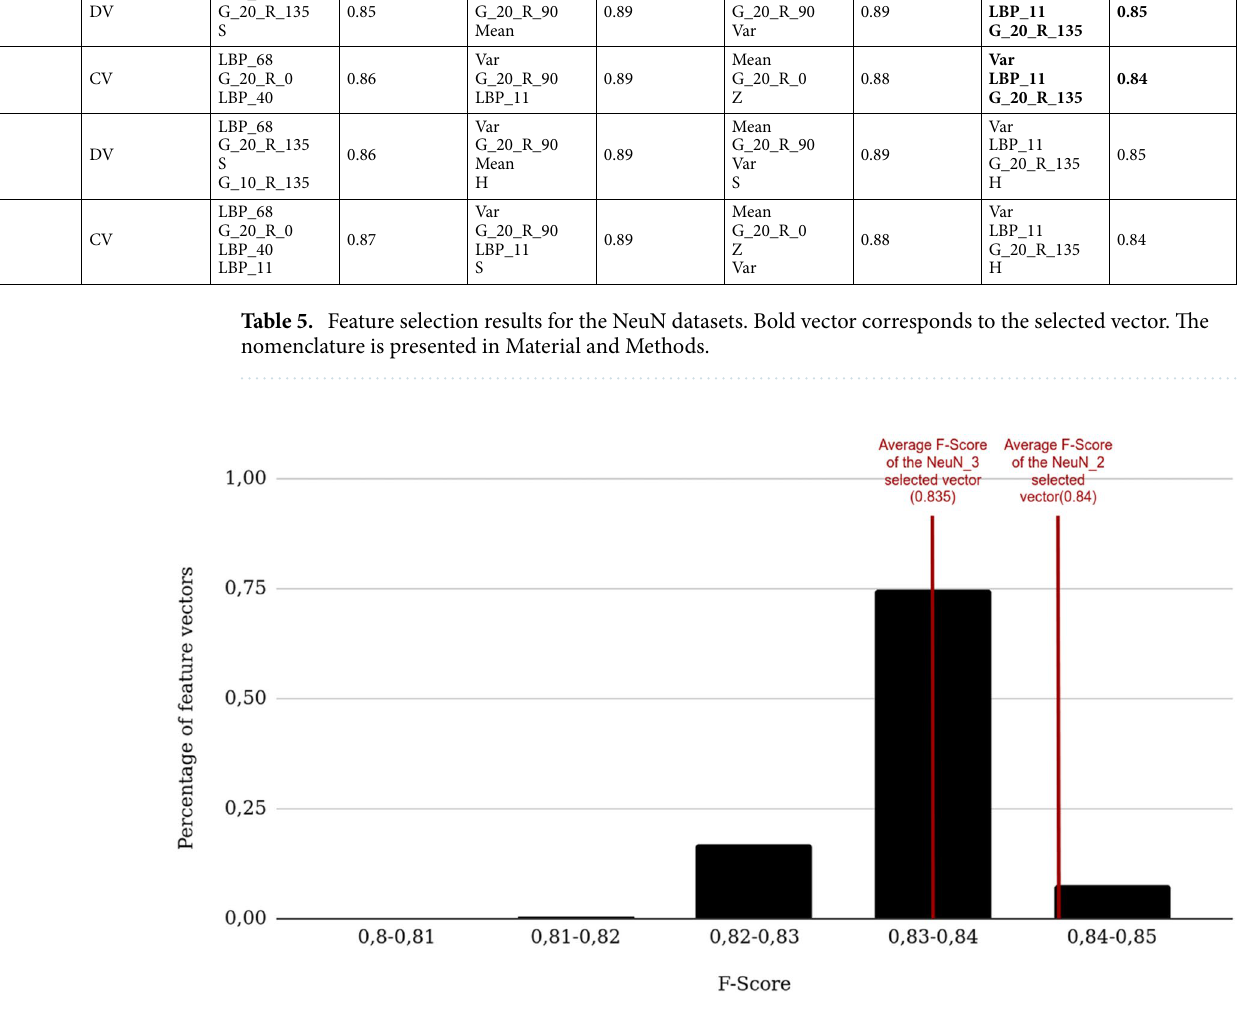
Figure 8. Magnification of Fig. 7 between 0.8 and 0.85 (5 bins for NeuN_pool). The red vertical lines represent the average F-Scores between the two validation conditions (DV/CV) for NeuN_2 and